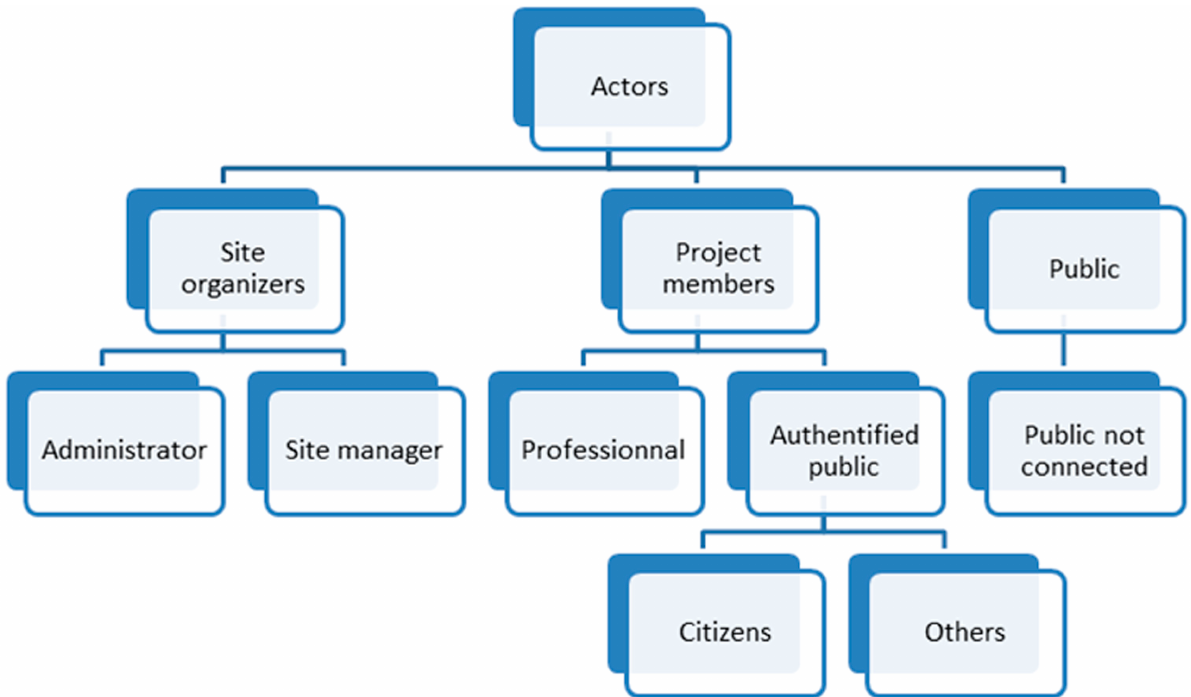
Figure 12. Users involved in the